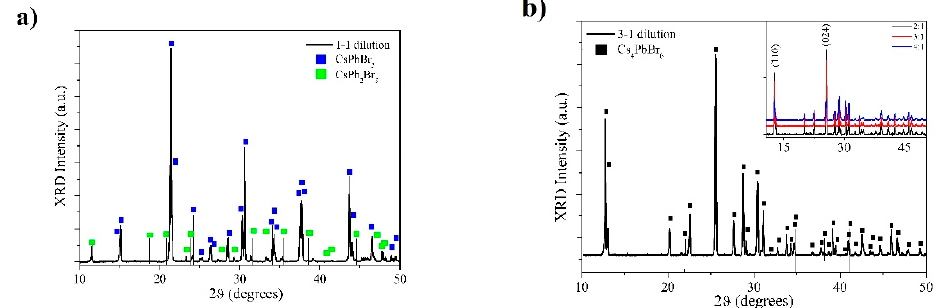
Figure 4. XRD spectra of perovskite films obtained from ( a ) 1:1 and (b) 3:1 precursor solution. In the inset of figure ( b ), patterns collected from films at different molar ratios are shown. Peaks at 2 ϑ = 21.40°, 2 ϑ = 30.60° and 2 ϑ = 43.60° are clearly present in the 1:1 film, confirming the